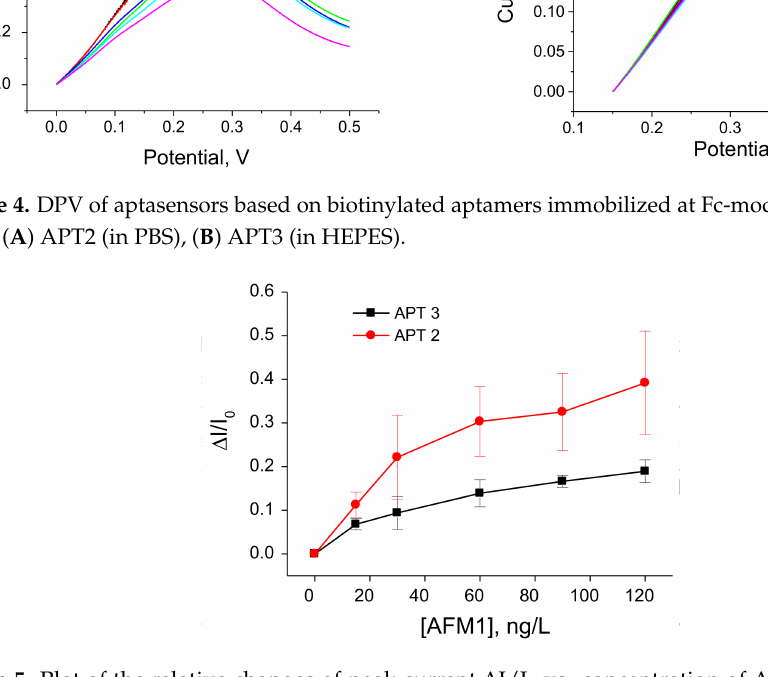
Figure 5. Plot of the relative changes of peak current ∆ I/I 0 vs. concentration of AFM1 constructed based on the DPV presented on Figure 4. ( ∆ I/I 0 = (I − I 0 )/I 0 , where I is the peak current at certain concentration of AFM1 and I 0 those without AFM1). Results represent mean ± SD obtained from 3 independent experiments in each